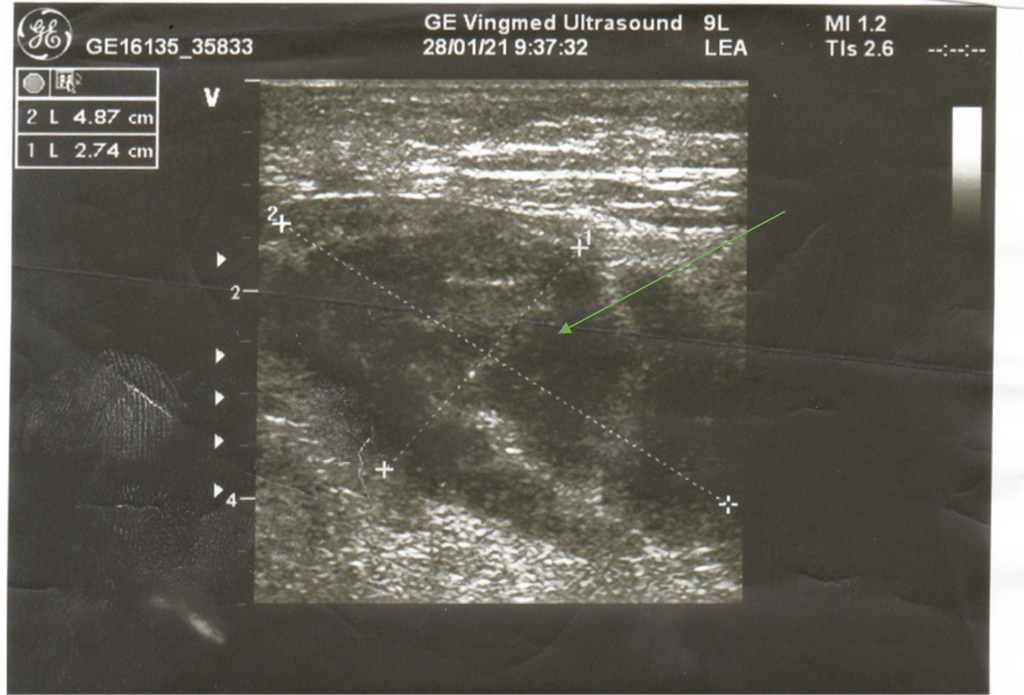
Figure 1. Oval lesion revealed in USG of the right thigh.